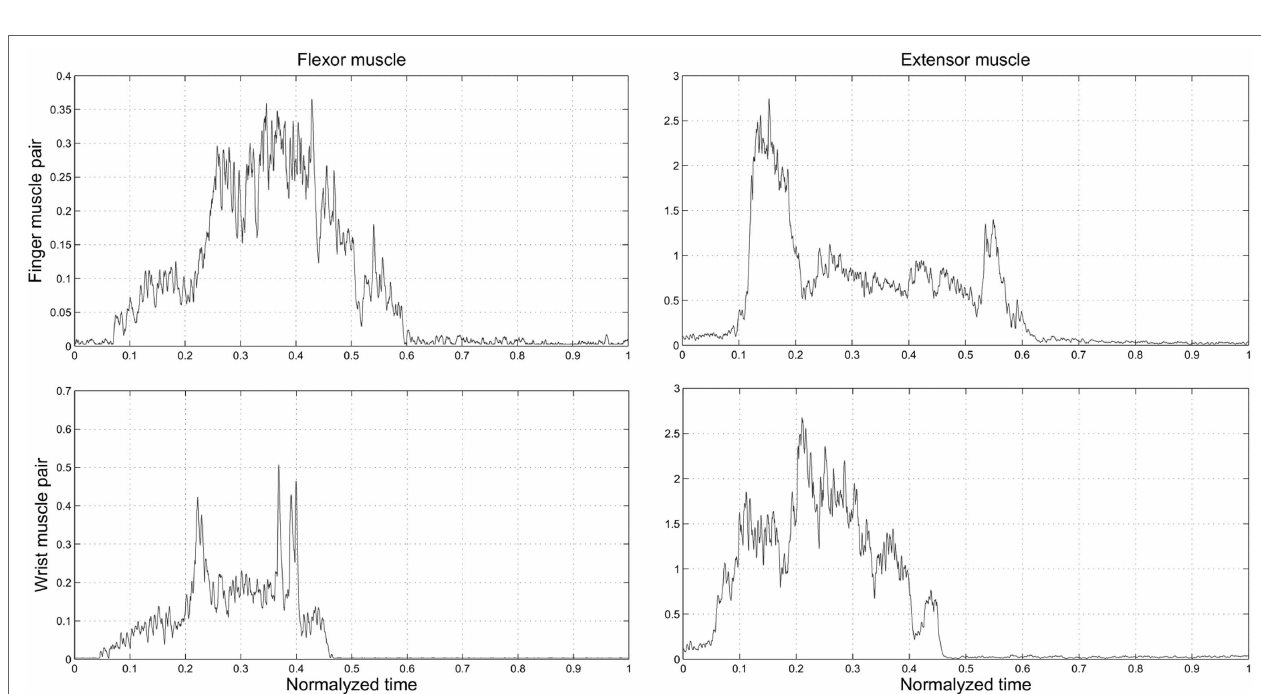
FIGURE 7 | Experiment 1 : spatial position of the fingertips (expressed in spatial coordinates x, y, and z) w.r.t. the time normalized on trial duration .